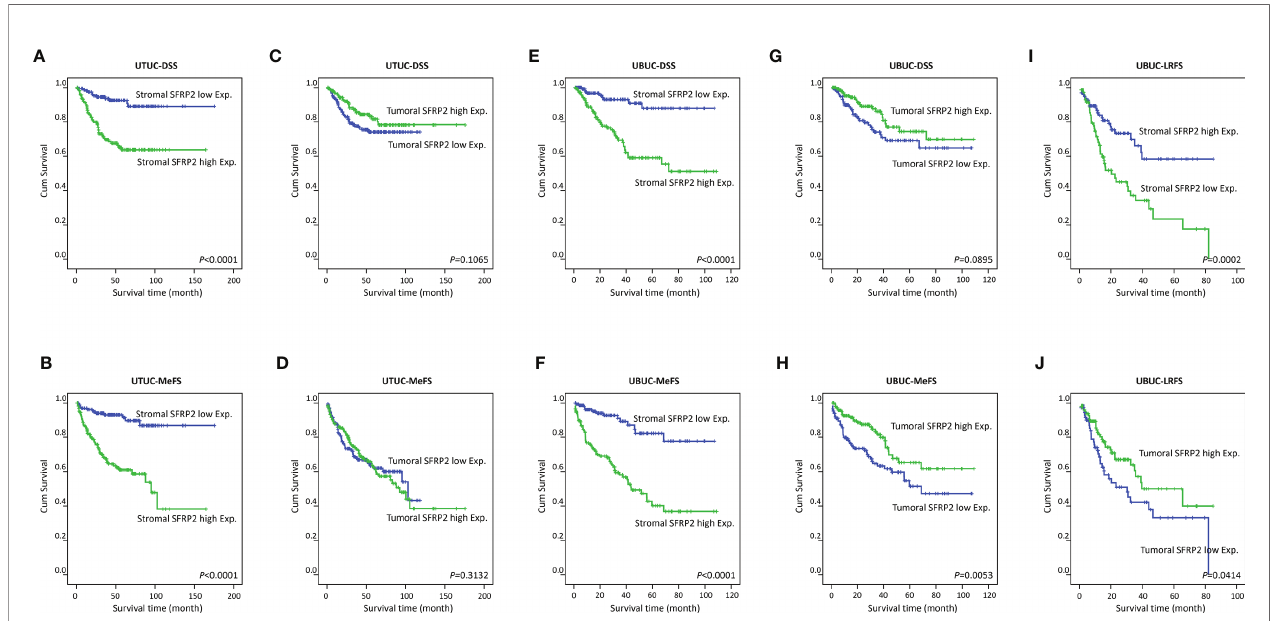
FIGURE 4 | Survival analysis. Kaplan – Meier curves show that high stromal SFRP2 immunoexpression conferred unfavorable prognostic effects on disease-speci fi c survival and metastasis-free survival in (A – D) UTUC and (E, F) UBUC patients. Low tumoral SFRP2 expression was adversely prognostic only for metastasis-free survival in (G, H) UBUC patients. Also, high SFRP2 immunoexpression in stroma and low SFRP2 immunoexpression in tumors were signi fi cantly correlated with poor local recurrence-free survival in (I, J) UBUC